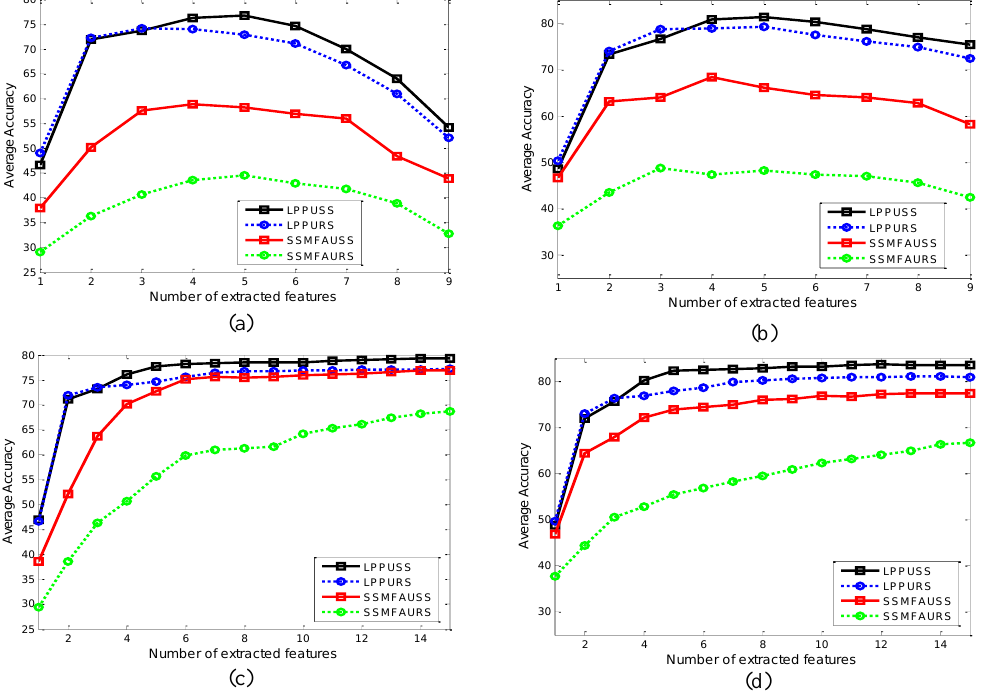
Figure 2. Average accuracy versus the number of extracted features for PU dataset, (a) GML classifier, 10 training samples,